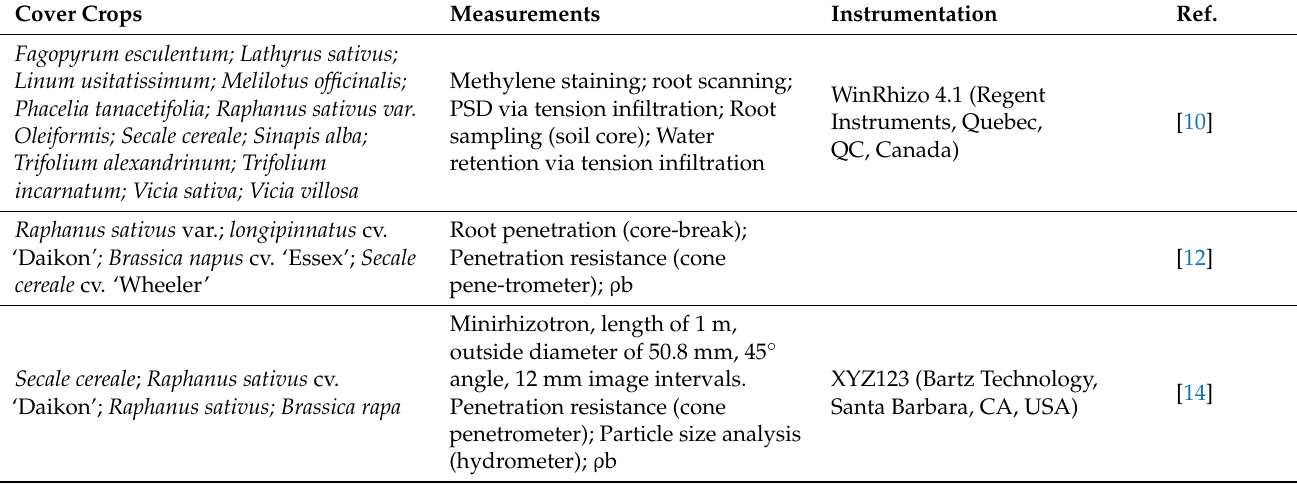
Table 2. Measurement techniques used in cover crop research for directly quantifying root-soil interactions ( ρ b—bulk density; PSD—pore size distribution). Cover Crops Measurements Instrumentation